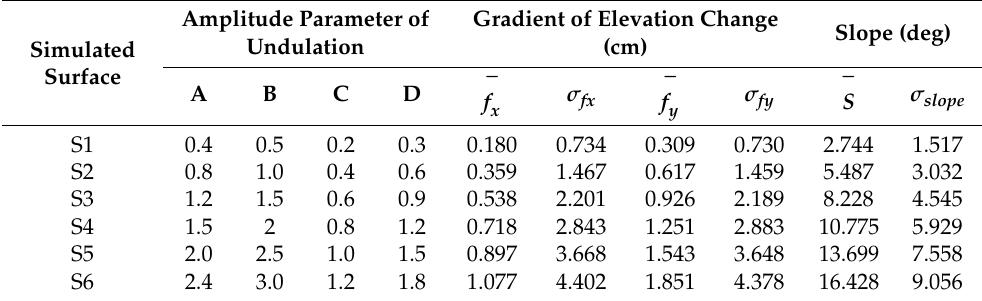
Table 1. Simulated surface parameters and complexity.